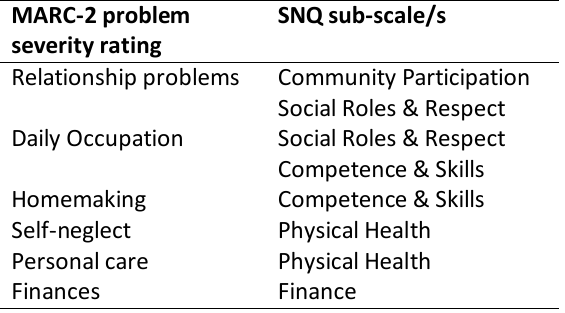
Table 1. Conceptual relationship map between cate- gorical MARC-2 problem severity ratings and SNQ sub-